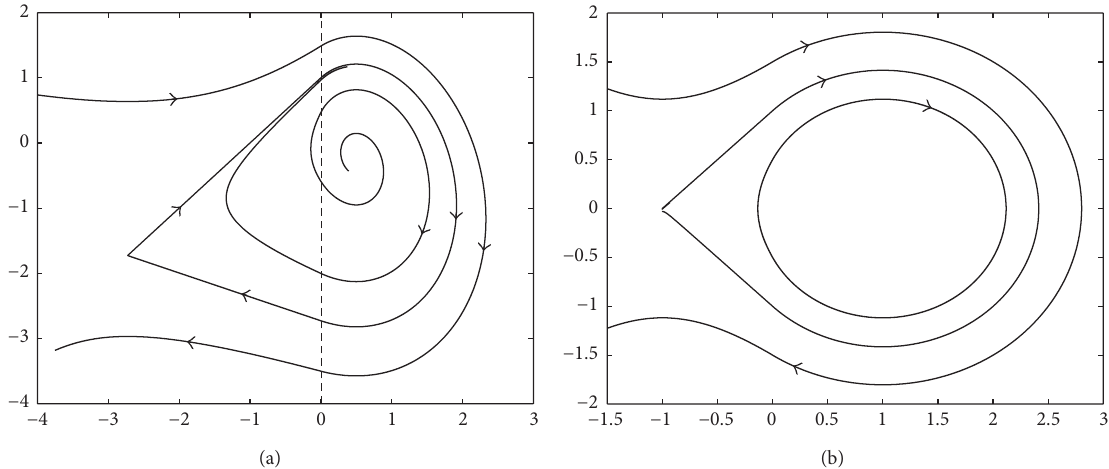
Figure 1: (a) Nondegenerate homoclinic orbit for the saddle-focus system. (b) Nondegenerate homoclinic orbit for the saddle-center system.